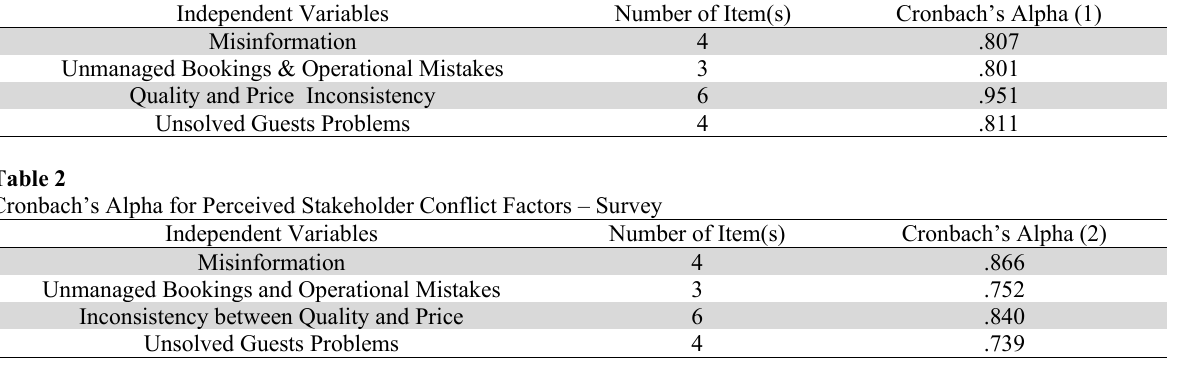
Cronbach’s Alpha for Perceived Stakeholder Conflict Factors -Pilot Study Independent Variables